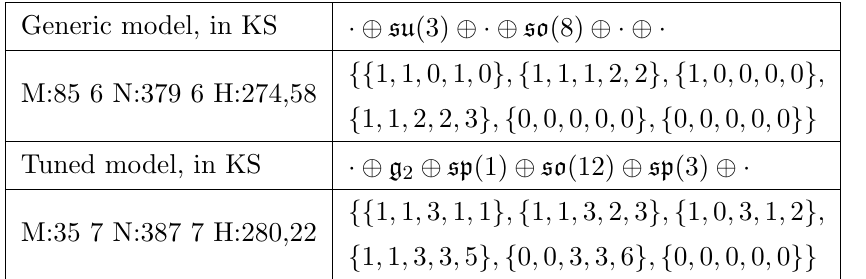
Table 13. An example of the non-existence of the stronger version of the Tate form: a tuning of a generic model over the base f(cid:0) 12 == (cid:0) 11 == (cid:0) 12 == (cid:0) 12 == (cid:0) 12 == (cid:0) 12 == (cid:0) 12 == (cid:0) 12 == (cid:0) 12 ; (cid:0) 1 ; (cid:0) 2 ; (cid:0) 2 ; (cid:0) 3 ; (cid:0) 1 ; (cid:0) 5 ; (cid:0) 1 ; (cid:0) 3 ; (cid:0) 1 ; (cid:0) 4 ; (cid:0) 1 ; 0 g on the last (cid:0) 4-curve with a so (12) gauge algebra (which forces gauge algebras on nearby curves). The Tate vanishing orders on the last six curves f(cid:0) 1 ; (cid:0) 3 ; (cid:0) 1 ; (cid:0) 4 ; (cid:0) 1 ; 0 g are indicated. While the weaker version of the Tate form f 1 ; 1 ; 3 ; 3 ; 5 g exists in the KS database, the stronger version f 1 ; 1 ; 3 ; 3 ; 6 g does not give rise to a Tate-Zariski decomposition with the desired gauge